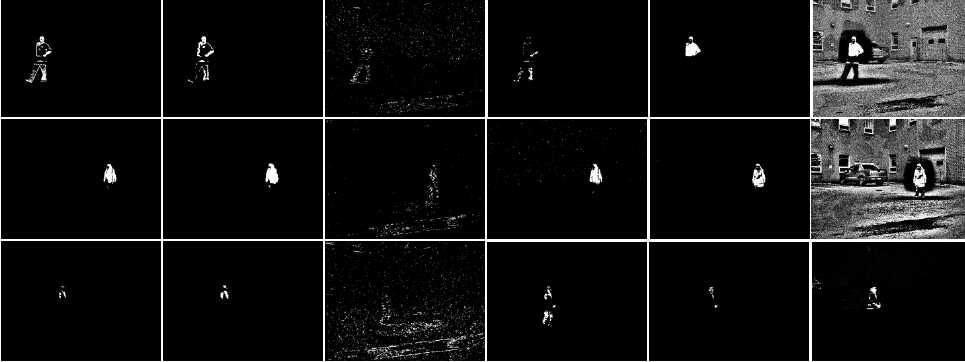
Figure 6. Moving object detection in day light outdoor scene ( Row 1: Object 1, Row 2: Object 2, Row 3 : Object 3)